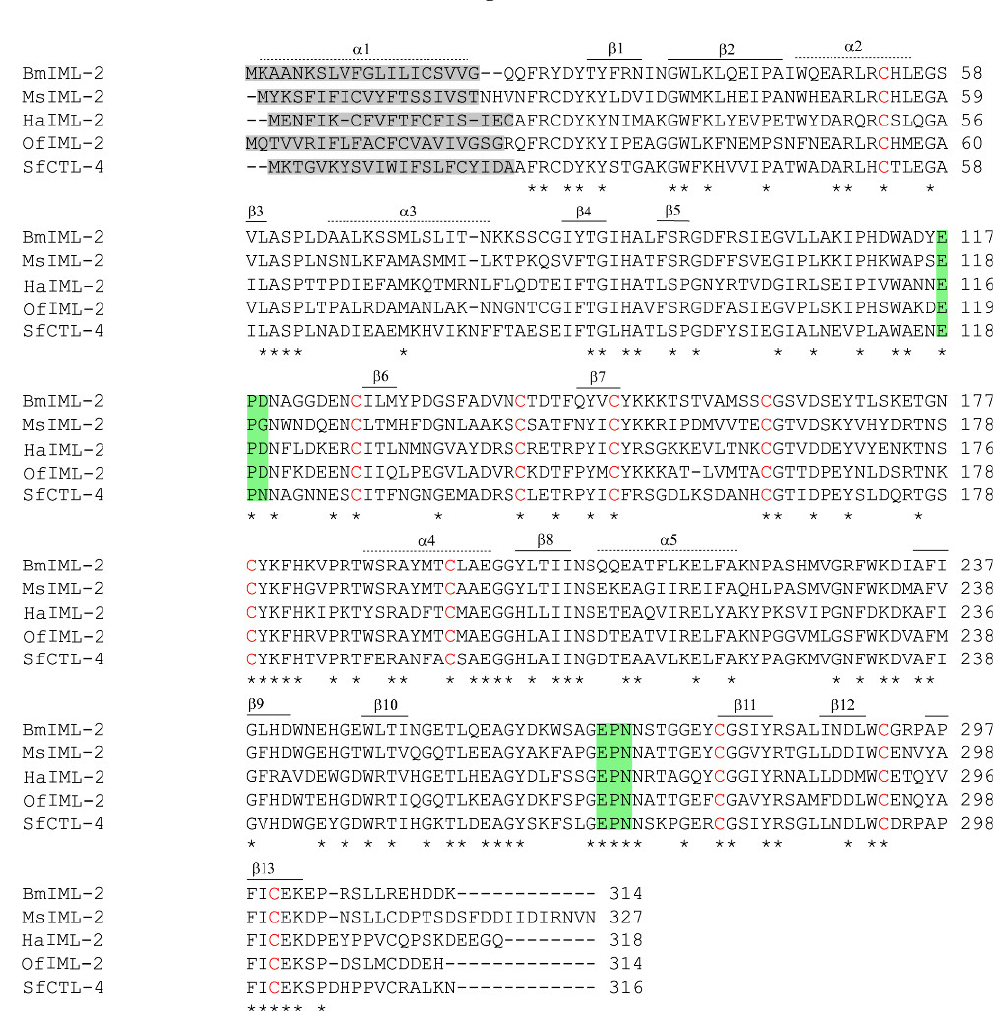
Figure 1. Multiple sequence alignment of B. mori IML-2. The predicted signal peptides are shaded with a gray background. The conserved cysteine residues in CTLD are shown in red font. The asterisk below the sequences represents the consistent amino acid residues. The key residues that define sugar-binding specificity are indicated with a green background. The secondary structure elements of B. mori IML-2 are marked above or below the sequences. The GenBank accession numbers are as follows: BmIML-2, NP_001165396.1; MsIML-2, XP_030038244.1; HaIML-2, ACI32834; OfIML-2,